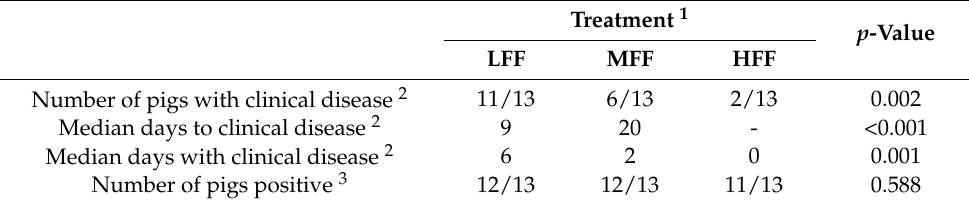
Table 2. Incidence of clinical disease of pigs inoculated with Brachyspira hyodysenteriae and fed a lowly fermentable diet (LFF), an intermediate fermentability diet (MFF), and a highly fermentable diet